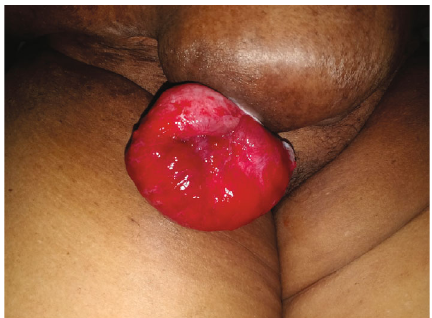
Figure 1: Preoperative image showing evisceration of small bowel with evidence of strangulation.